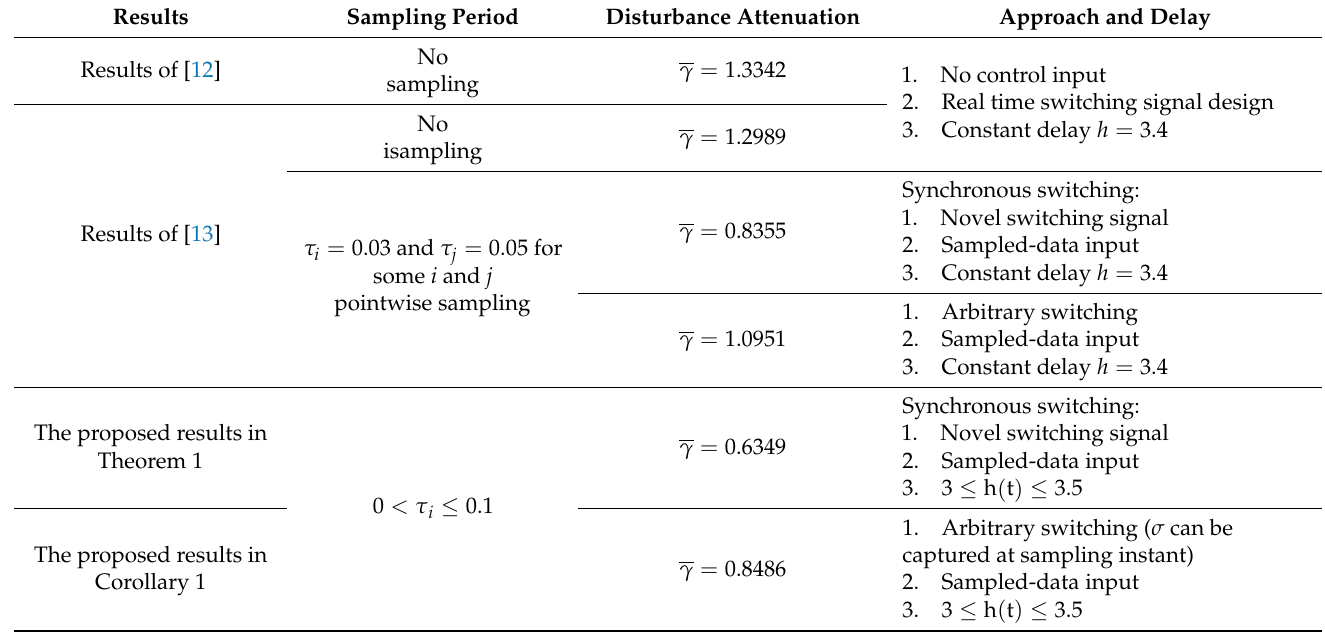
Table 5. Comparing the obtained results with published